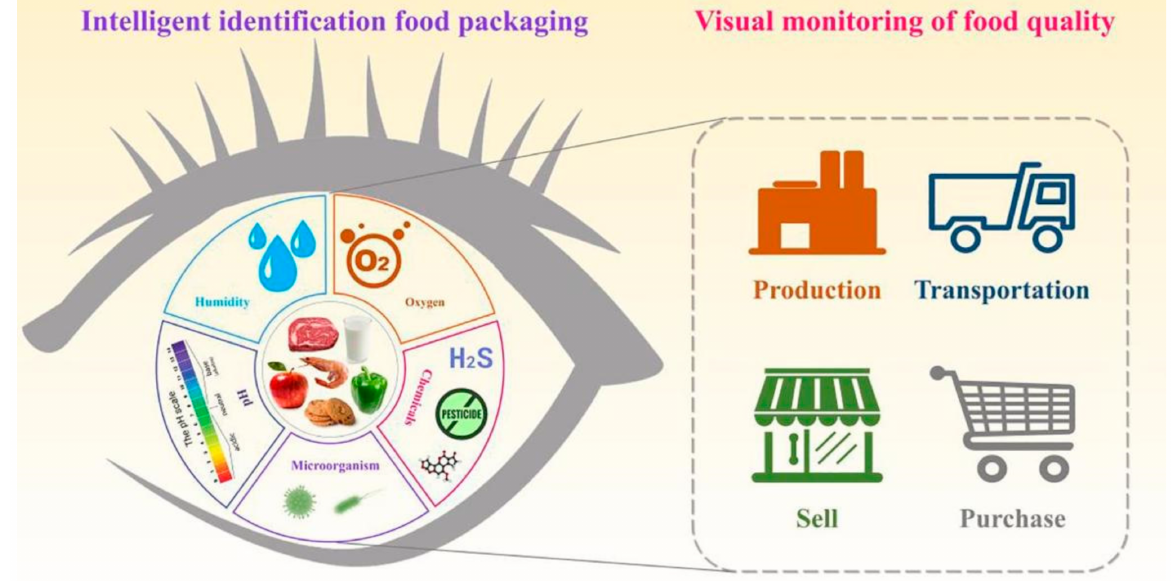
Figure 1. Intelligent food packaging monitors food quality. Reproduced from Ref. [8] with